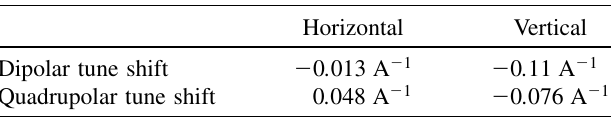
TABLE III. Summary of the measured tune shifts under single-bunch